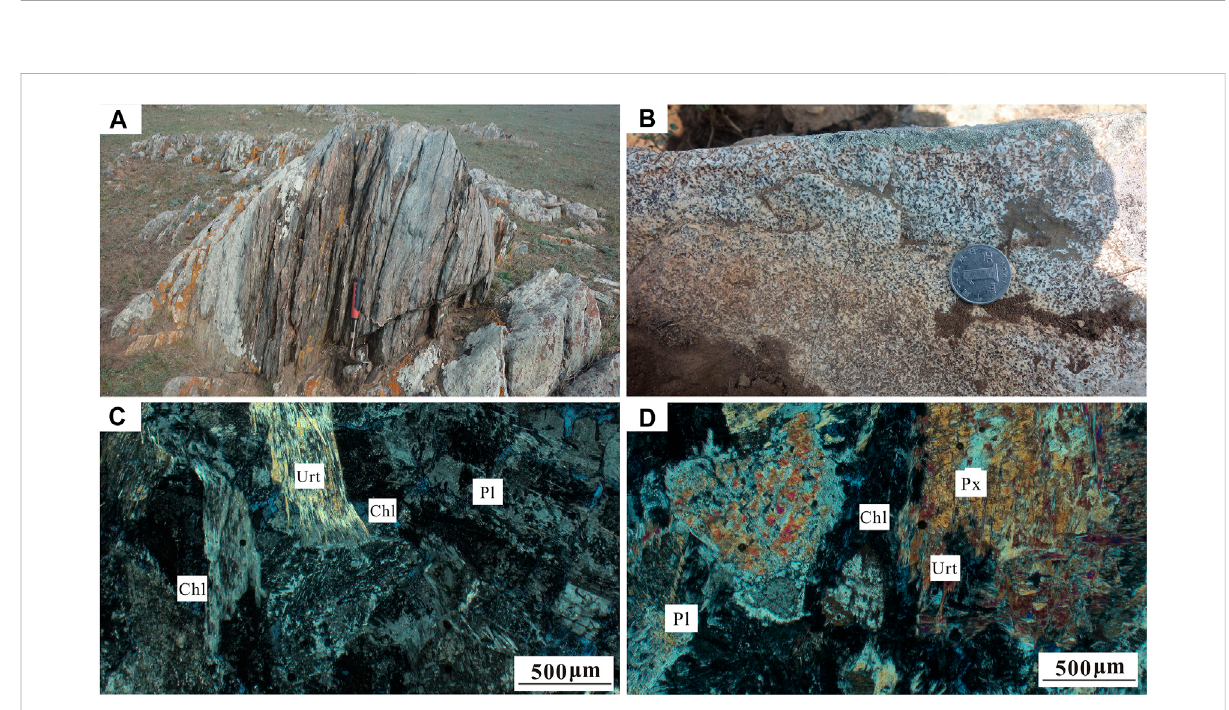
FIGURE 3 Macrofeatures and photomicrographs of the gabbro in Diyanmiao ophiolite. (A) -outcrop of gabbro; (B) -hand specimen of gabbro; (C,D) - photomicrographs of gabbro; Pl, plagioclase; Px, pyroxene; Chl, chlorite; Urt,